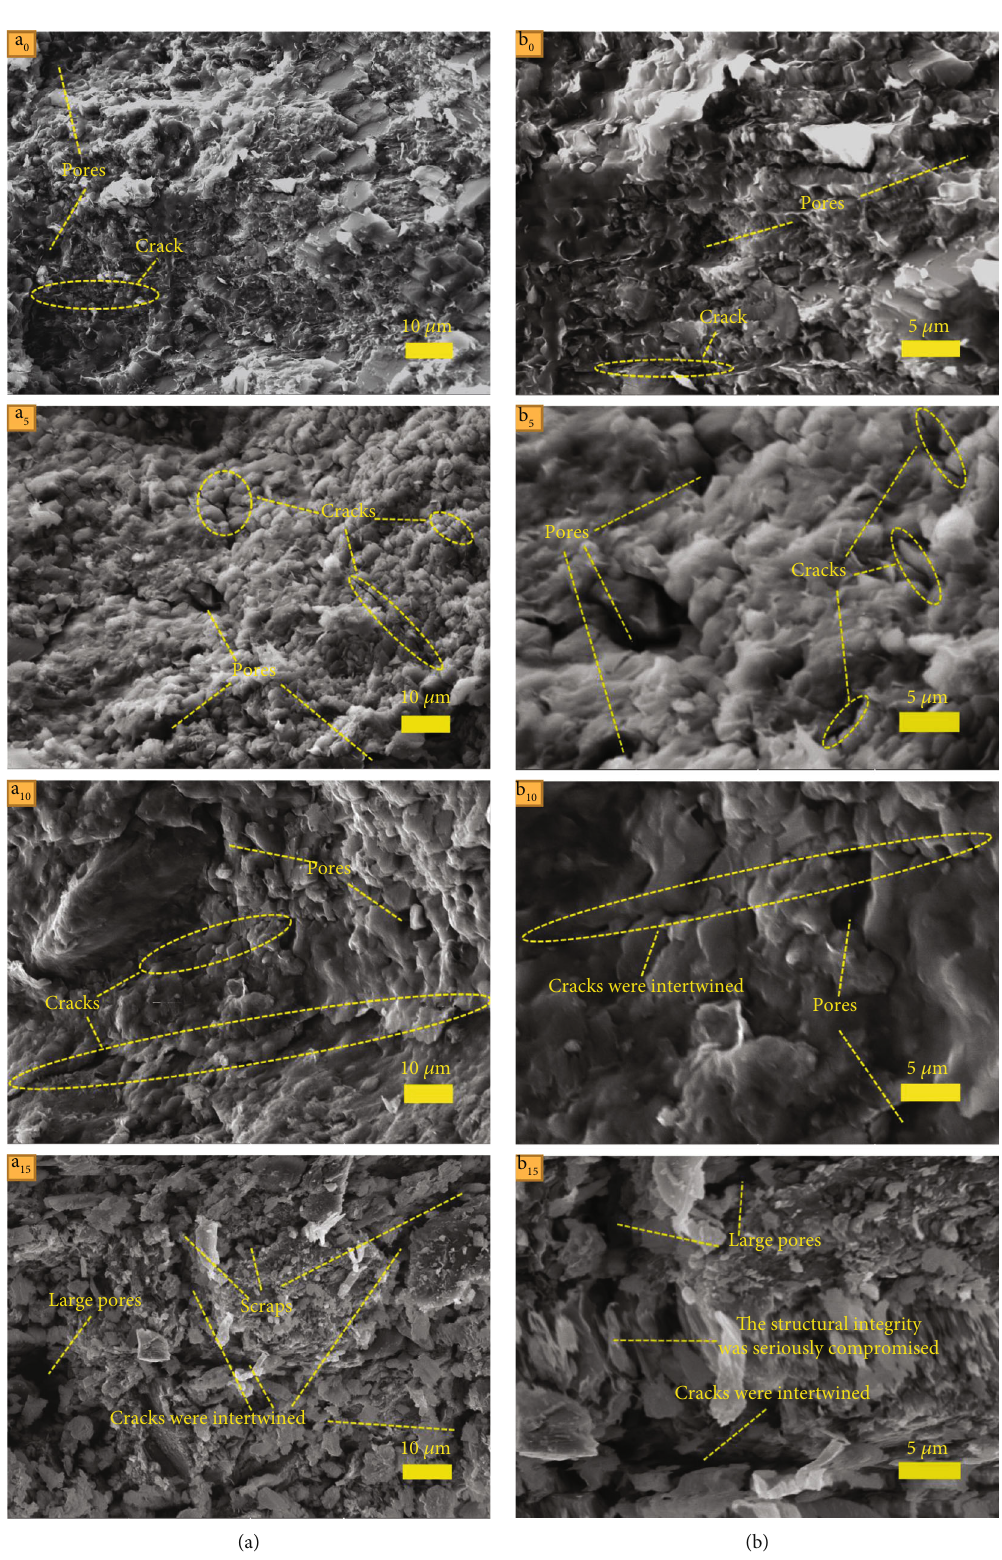
Figure 11: SEM images of samples experiencing dry – wet cycling (a,